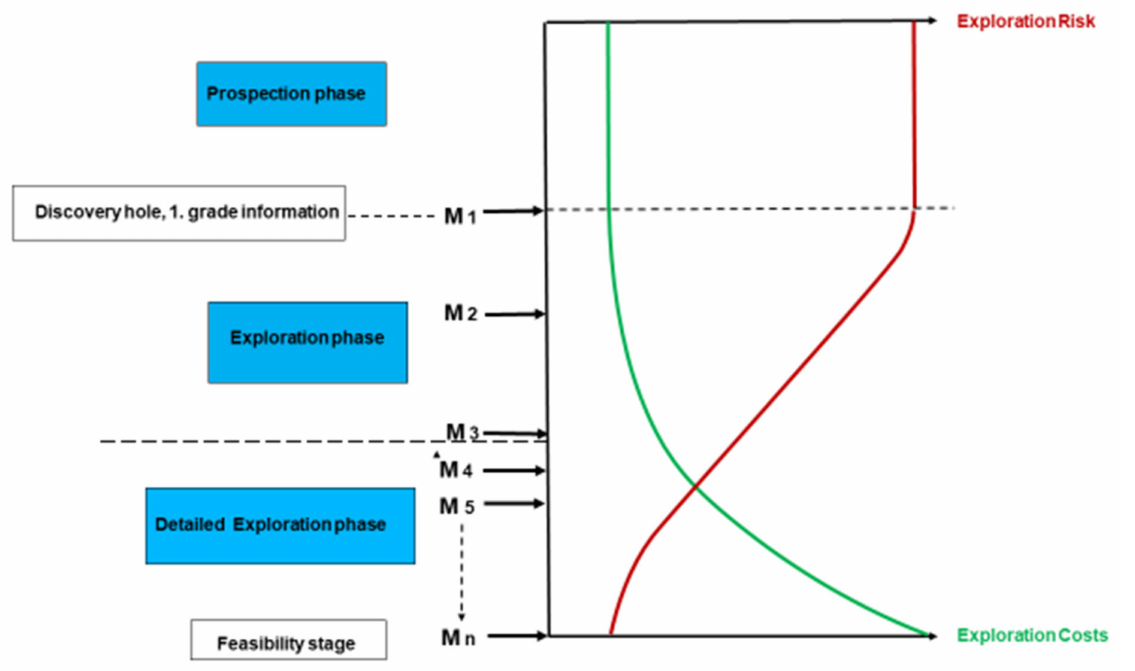
Figure 1. Progress of exploration with milestones, relative risks, and relative exploration costs [18] (with permission of Bolet í n Geol ó gico y